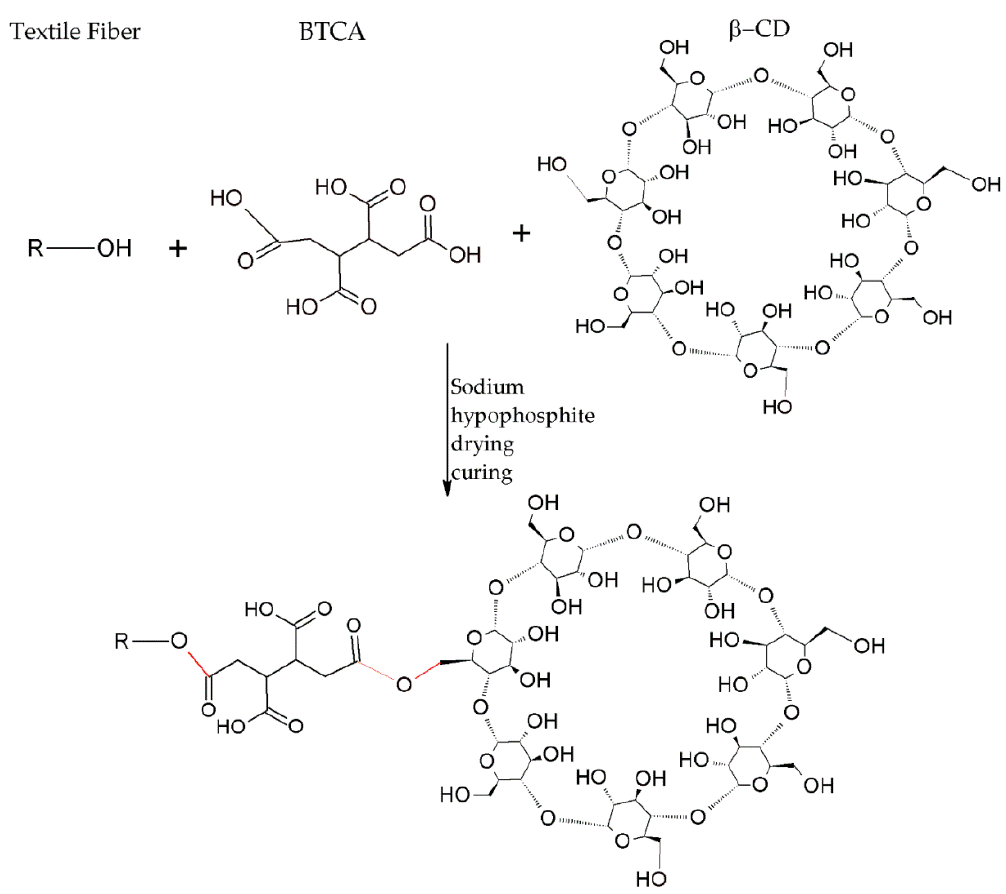
Figure 7. Direct connection of the β-CD to the textile fiber via crosslinking.